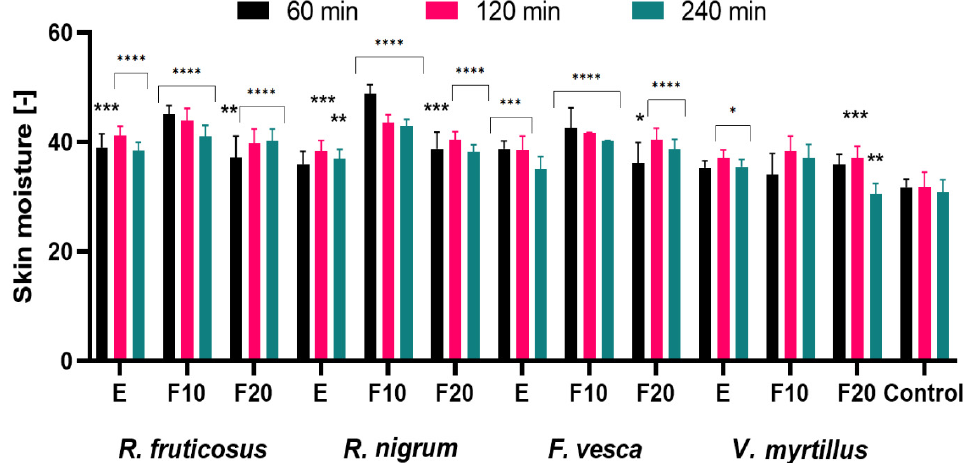
Figure 11. The influence of R. fruticosus L., R. nigrum L., F. vesca L., V. myrtillus L. extract and kombucha ferments (at concentration of 300 µ g/mL) on skin hydration. Data are the mean ± SD of five independent measurements. **** p < 0.0001, *** p < 0.0008, ** p < 0.0080, * p < 0.050. versus the control.